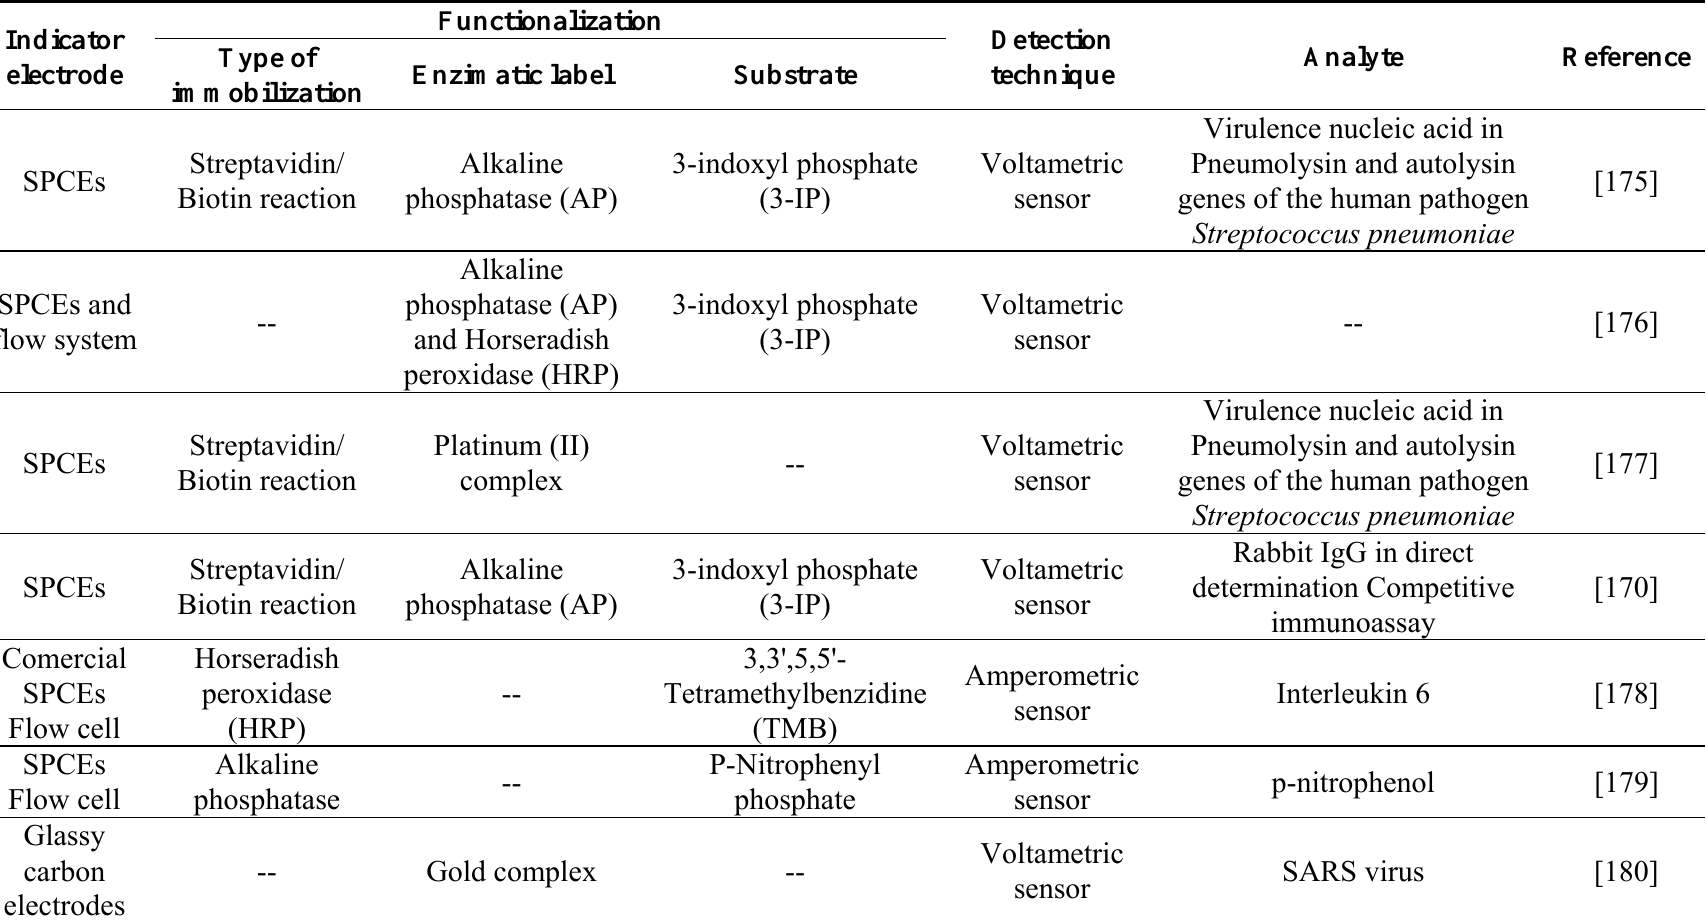
Table 3. Selective screen-printed